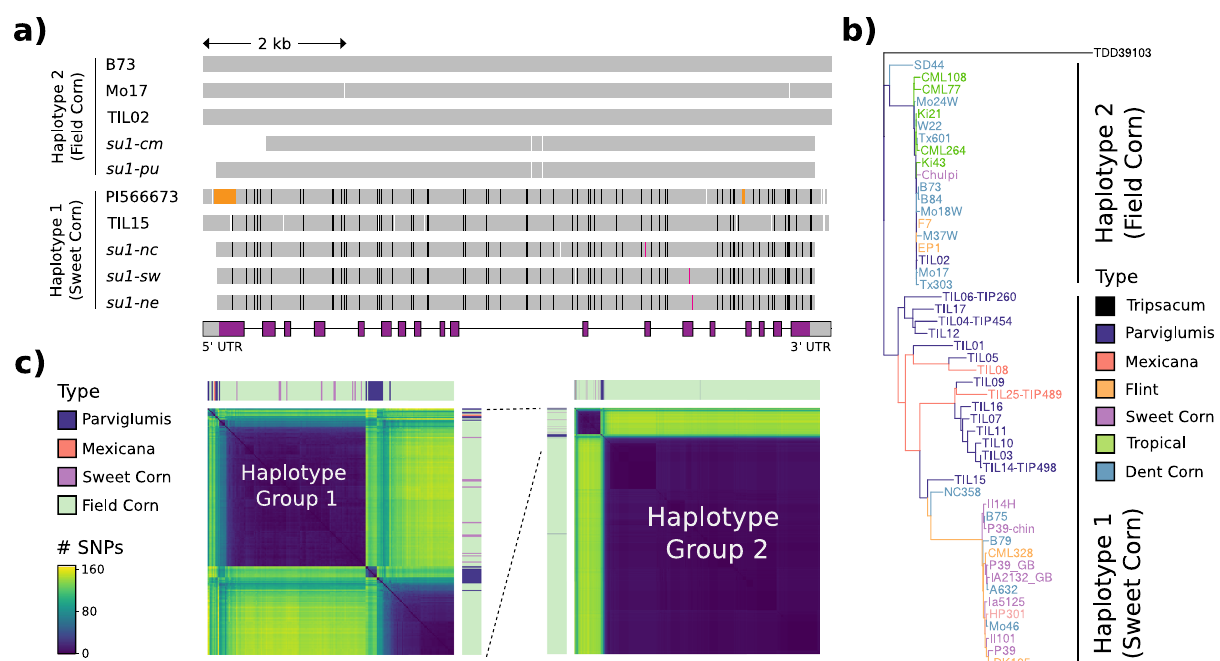
Fig. 4 Two different haplotypes of the su1 locus. a Haplotypes at the su1 locus. Colored-coded vertical lines represent SNPs or deletions of 5 bp or less relative to the B73 reference sequence. Black lines denote SNPs present in su1-ne , white lines indicate SNPs in other alleles not shared with su1-ne , magenta lines indicate causative agents of the su1- defect, and orange blocks indicate deletions in PI566673 115 ( Zea mays ssp. mexicana ) relative to B73. Every variation from B73 is indicated. In the gene model black lines indicate introns, gray bars indicate untranslated region exons, and purple bars indicate coding sequence exons. The fi gure is drawn to scale except for a few SNP locations that have been slightly adjusted to allow visual resolution. The sequences of regions not covered by gray bars were not determined. b Neighbor-joining su1 tree rooted in Tripsacum dactyloides , containing teosinte samples and representatives of the two dominant su1 haplotype groups. c Heatmap of the distance matrix calculated from the 165 SNPs within the full length sugary1 gene. The left part of the panel represents a blowup of the full heatmap, presented on the right corner of the same panel. Haplotype group 1 is referred in the text as the sweet corn haplotype while haplotype 2 is the fi eld corn